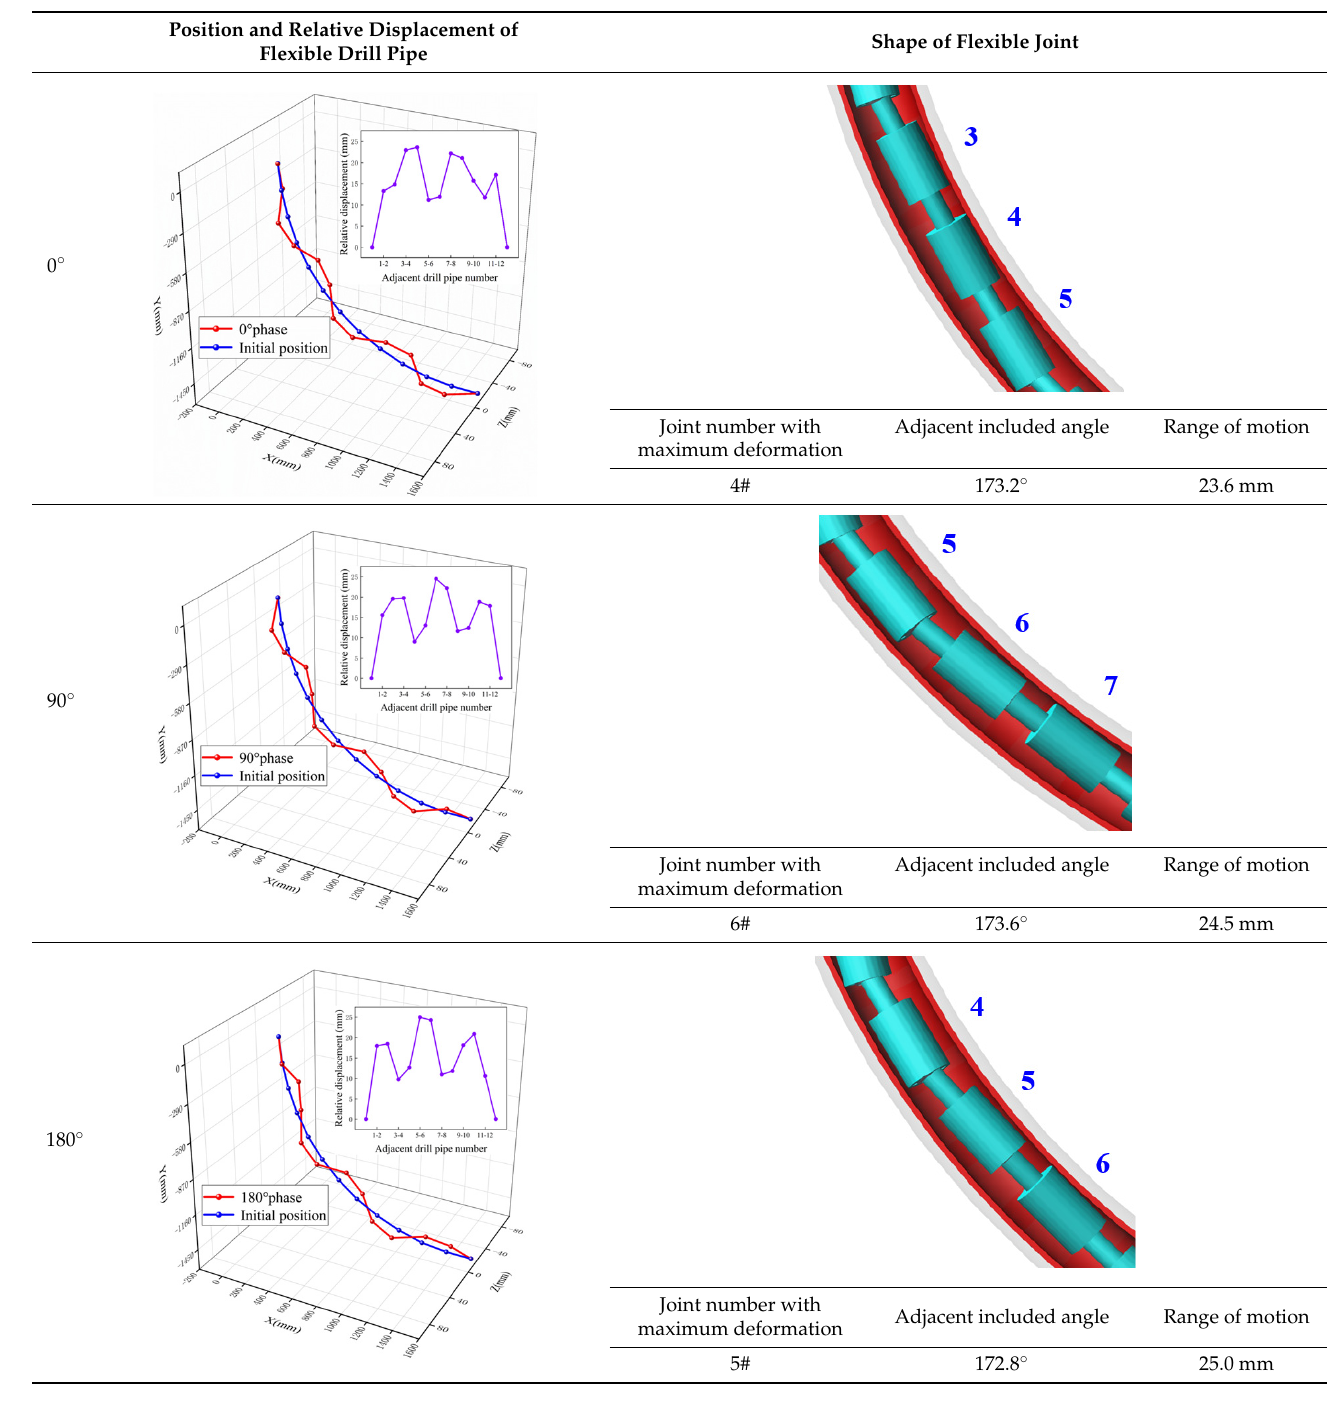
Table 3. Flexible joint geometry at different moments.